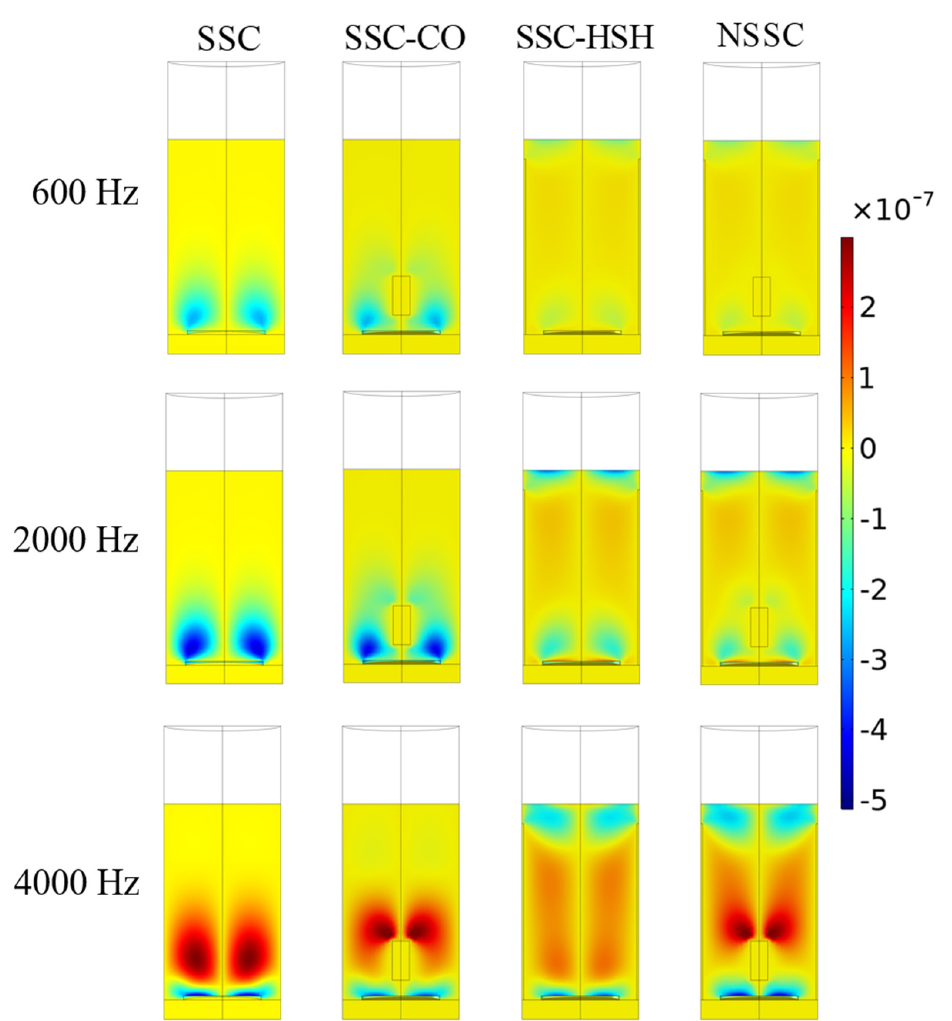
Figure 8. Radial velocity nephogram of each configuration (unit: m/s).